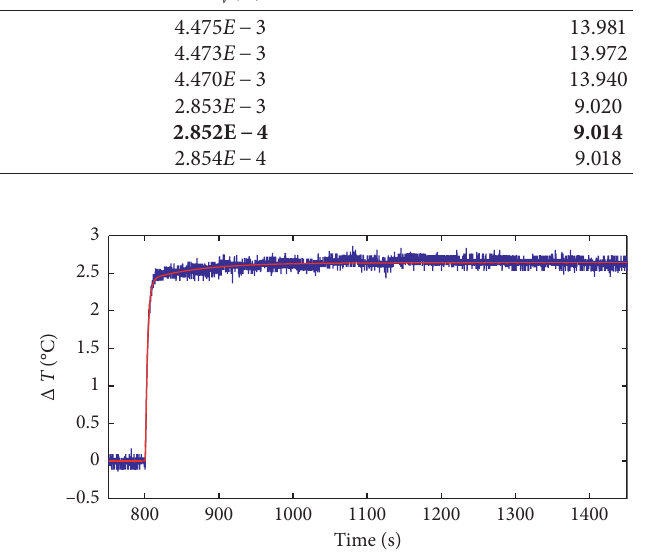
Table 7: Ranking of estimated linear models for the thermal process. Models 4 p and 5 p have been excluded due to their MDL high values. Structure